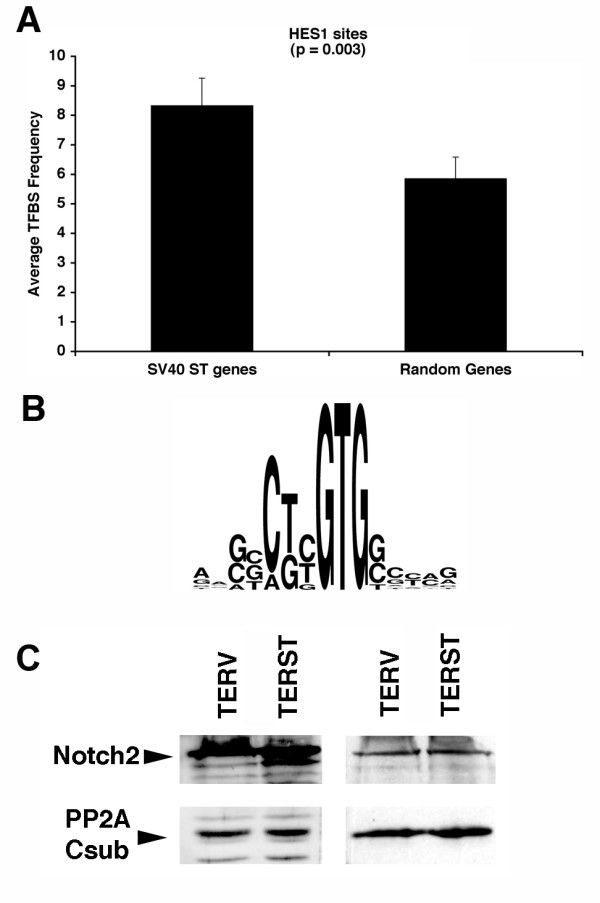
(A) Plot of the average frequency of HES1 sites in genes upregulated by ST > 2-fold and in a random control list of 200 genes. (B) Sequence logo of the position weight matrix for HES1 sites based on the TRANSFAC database.(C) Immunoblot of whole cell lysates prepared from HEK-TERST and HEK-TERV cells and probed with antibodies specific for the activated human Notch-2. Activated Notch-2 is equally present in both cell lines (right), although longer exposures (left) reveal a shorter isoform that is more abundant in cells expressing SV40 ST.